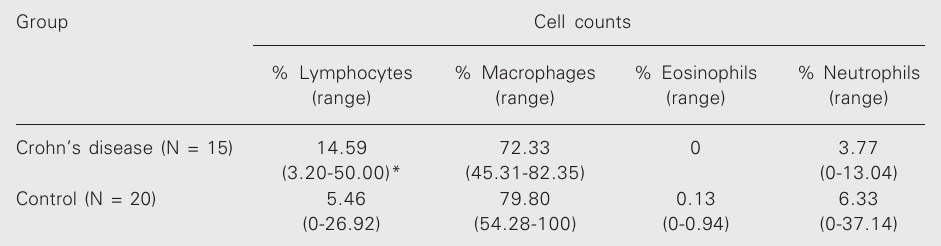
Table 1. Differential cell counts of induced sputum in Crohn’s patients and healthy controls. Group Cell counts % Lymphocytes % Macrophages % Eosinophils (range) (range) (range) (range) Crohn’s disease (N = 15)